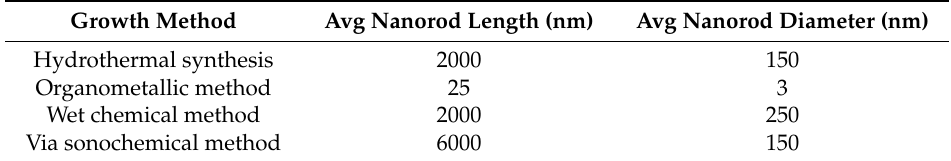
Table 1. Average diameter and average length of ZnO nanorods grown by common